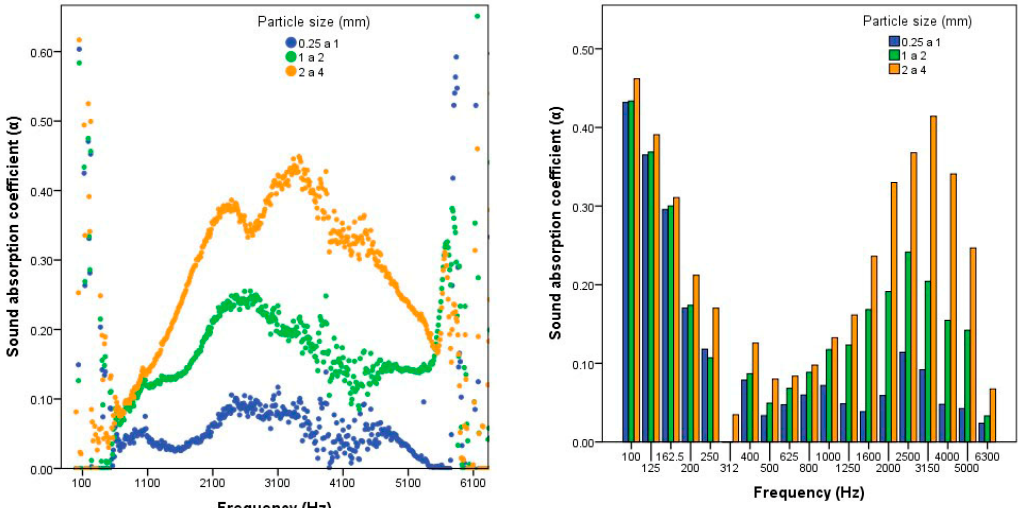
Figure 5. Coefficient α according to the particle size obtained in the test and for standardised octave frequency bands.